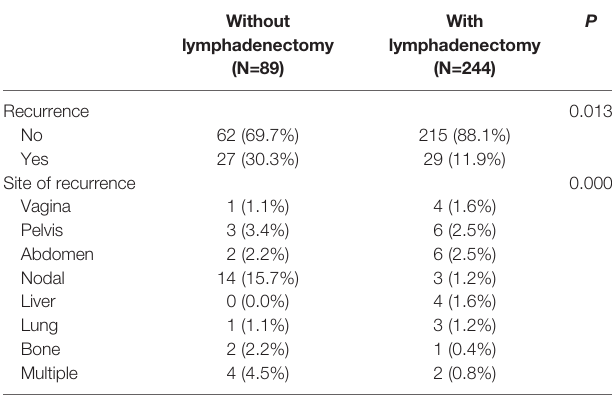
TABLE 2 | Patterns and rates of recurrence by systematic lymphadenectomy vs. nodes conserved. Without With lymphadenectomy lymphadenectomy